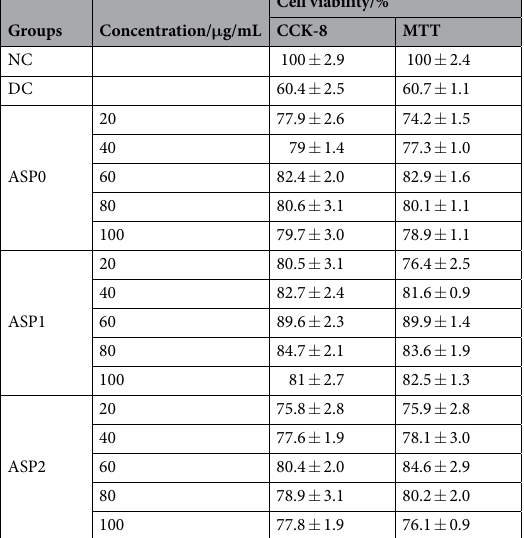
Table 3. Comparison of CCK-8 and MTT assays to detect the changes in damaged HK-2 cells activity after APS repair with different Mws.